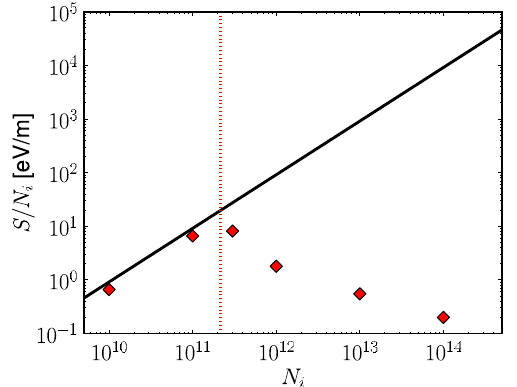
FIG. 1. Stopping power as a function of the number of parti- cles in the bunch. The analytic result obtained from Eq. (12) is represented by the solid curve. The symbols represent the results obtained from the simulation. The red dashed line corresponds to (cid:6) ¼ 10 . (cid:7) z 0